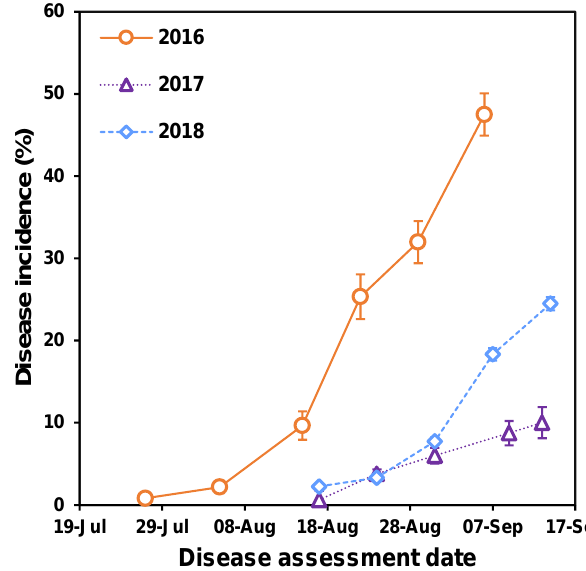
Figure 4. Progress of soybean sudden death syndrome (SDS) foliar disease incidence (%) over time in the 2016, 2017, and 2018 soybean growing seasons at Marsden Farm. Each dot represents the overall mean incidence of diseased plants in quadrats classified as diseased (i.e., quadrats where > 5% of the plants had foliar symptoms) on a given date, calculated from 240 (2016, 2017) or 228 (2018) quadrats in soybean plots. Error bars indicate standard error of mean disease incidence.